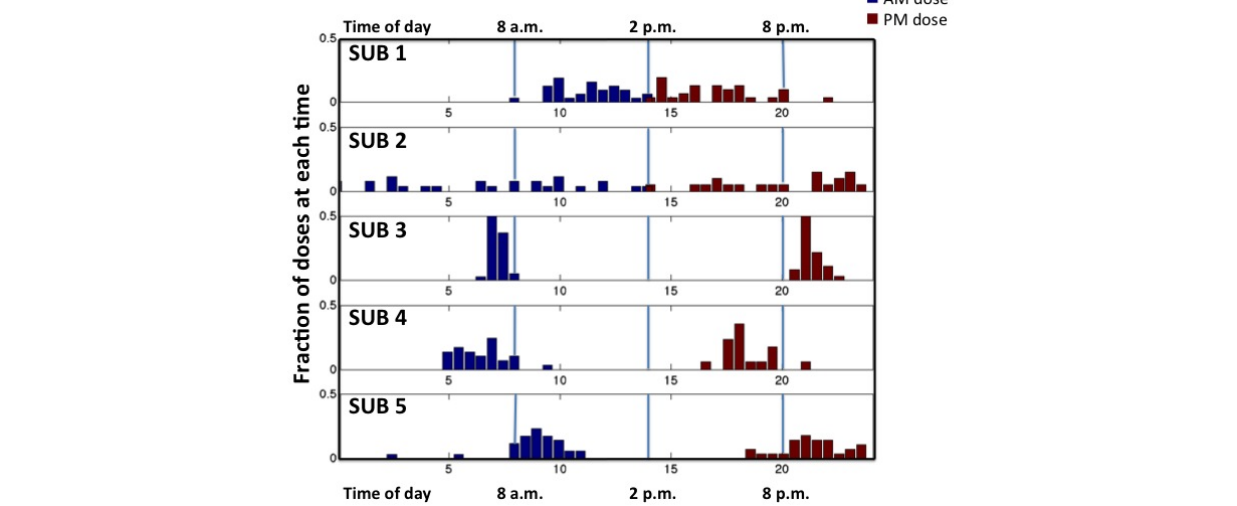
Figure 5. Frequency distribution of the time of day at which the subjects ingested